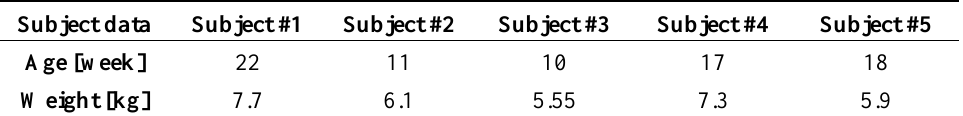
Table 3. Infants’ age and